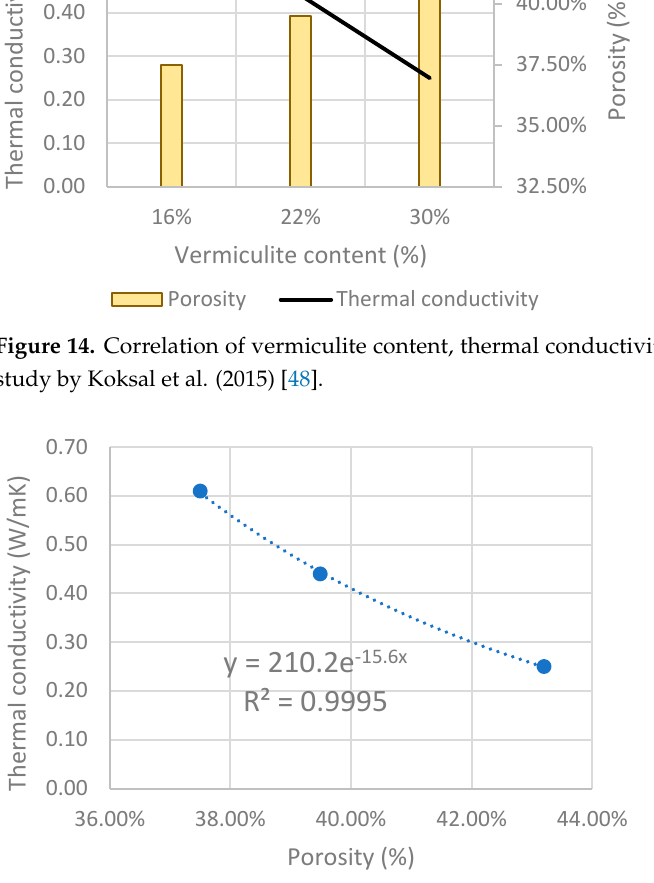
Figure 15. Relationship between thermal conductivity and porosity results from the study by Koksal et al. (2015) [48].